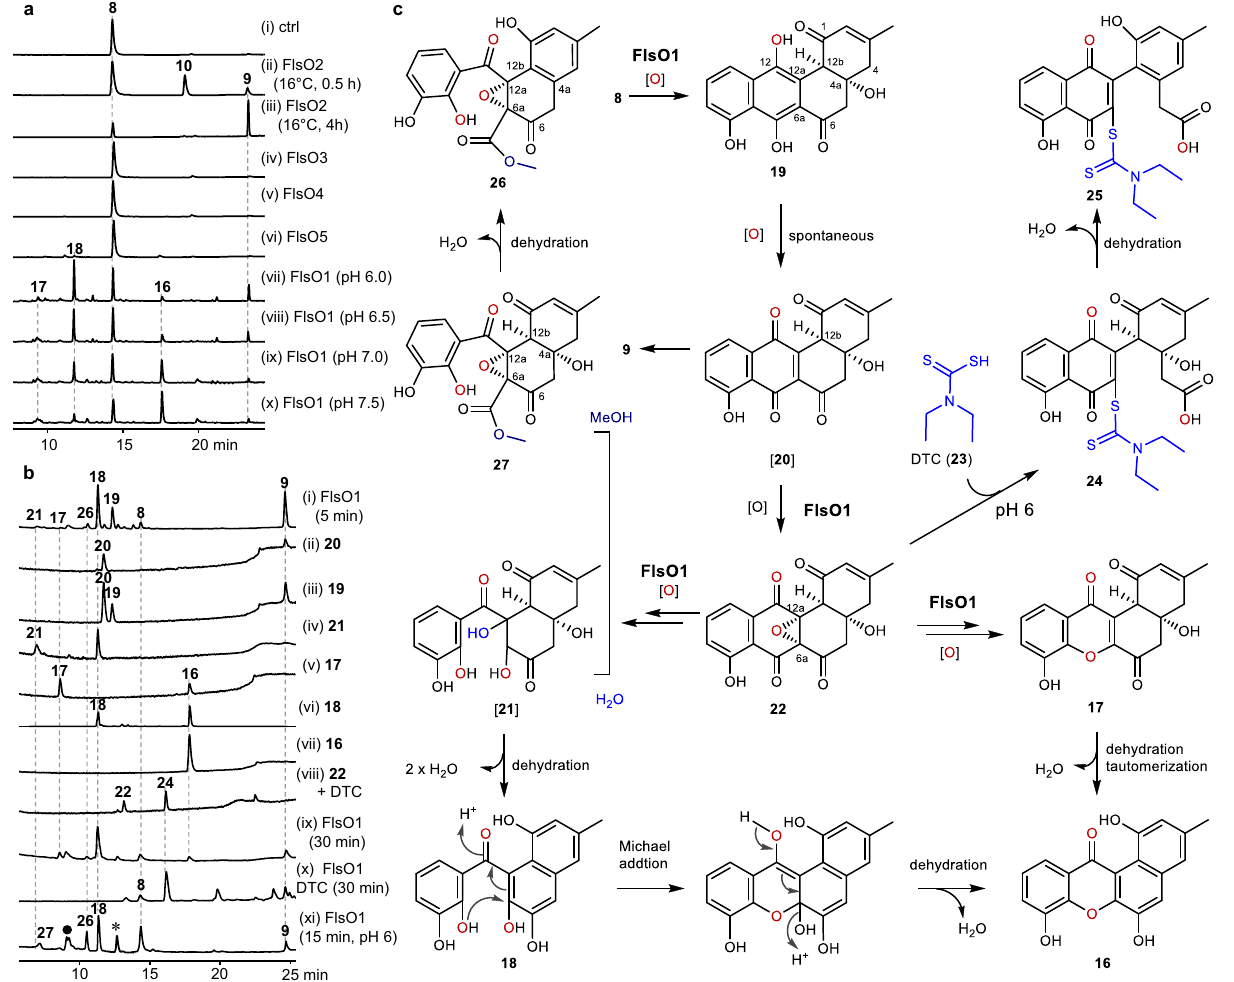
Fig. 2 | Biochemical characterization of FlsO1-catalyzed formation of 16 from PJM ( 8 ). a HPLC analysis of enzyme assays. The assays were performed by incu- bationof200 μ M 8 inthepresenceof2mMNADPH:(i)control(noenzyme);(ii,iii) 5 μ M FlsO2; (iv) 10 μ M FlsO3; (v) 10 μ M FlsO4; (vi) 10 μ M FlsO5; and (vii – x) 10 μ M FlsO1. The reactions were performed in PBS buffers (50mM) at 16°C for 0.5h (ii) and 4h (iii) for the detection of 10 , or at30°Cfor 30min (iv – x). The pH values for PBS buffers were pH 7.0 (i – vi and ix), pH 6.0 (vii), pH 6.5 (viii) and pH 7.5 (x), respectively. b HPLC analysis of short-time FlsO1 assays and the putative reaction intermediates. (i) FlsO1 reactions with PJM ( 8 ) for 5min in PBS buffers (50mM,